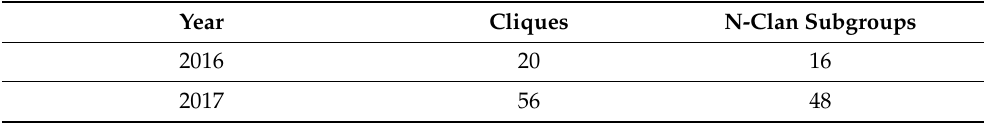
Table 7. The substructure of the food safety risk transfer network in the five provinces from 2016 to